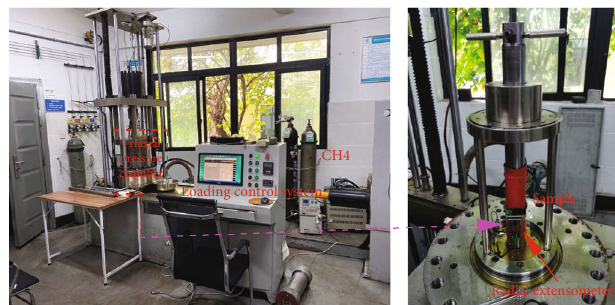
Figure 2: Thermal- fl uid-solid coupling seepage apparatus for coal and rock containing gas.